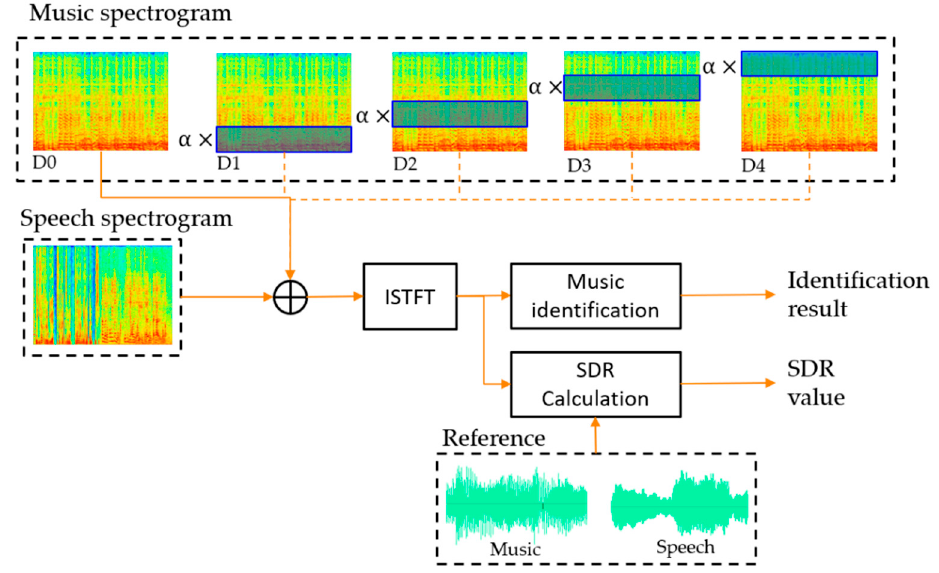
Figure 11. Experimental structure of SDR measurement according to distortion by frequency band.